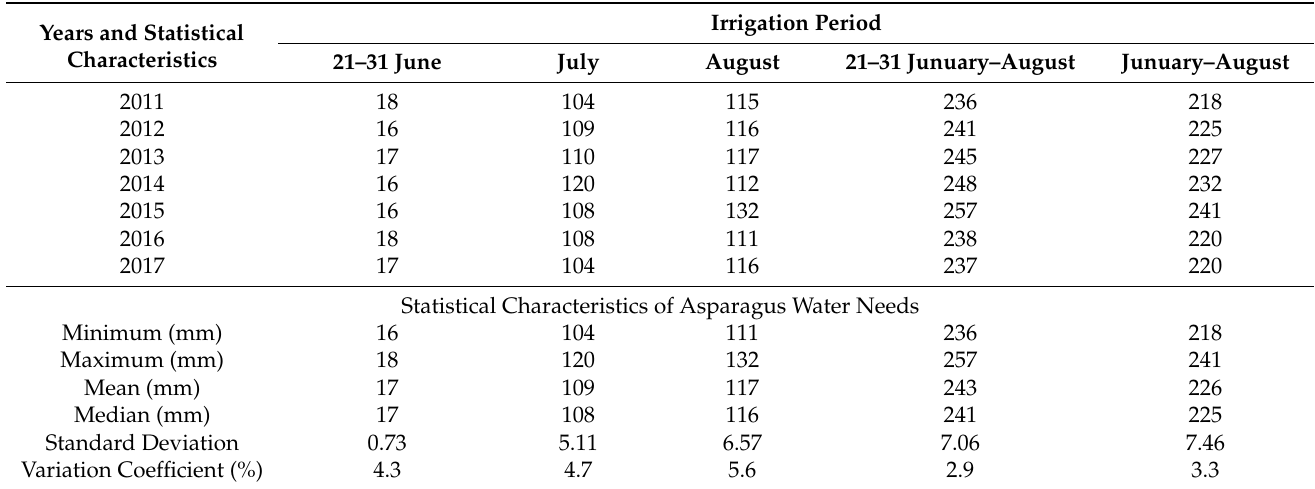
Table 3. Water needs (mm) of asparagus plants during the irrigation period under drip irrigation conditions in the years 2011–2017.